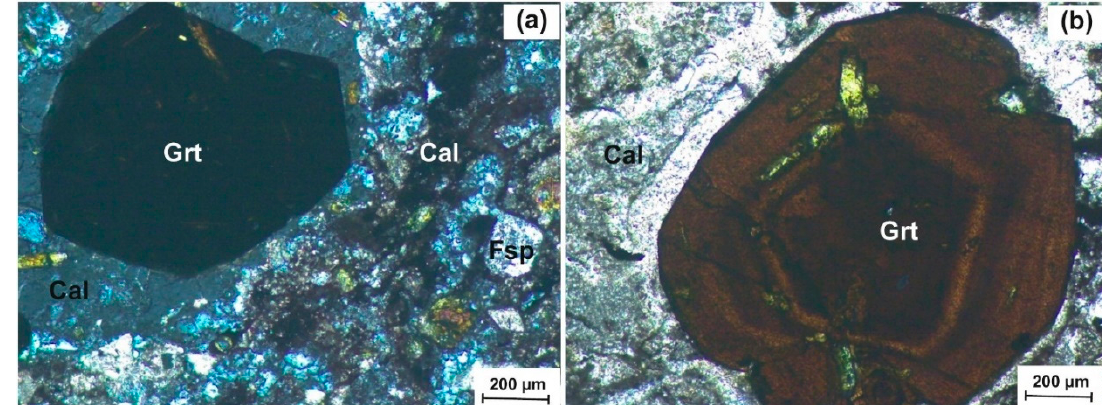
Figure 3. Photomicrographs of a garnet phenocryst in a calcitic groundmass: ( a ) under XPL ( b ) under PPL-large euhedral garnet phenocryst showing variation in color. A few K-feldspar grains are also visible. Abbreviations of mineral names are taken from [41].